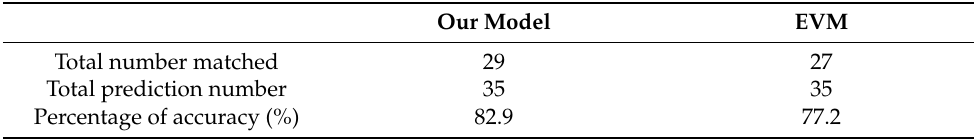
Table 7. Comparison between Our Model and EVM. Our Model EVM Total number matched 29 27 Total prediction number 35 35 Percentage of accuracy (%) 82.9